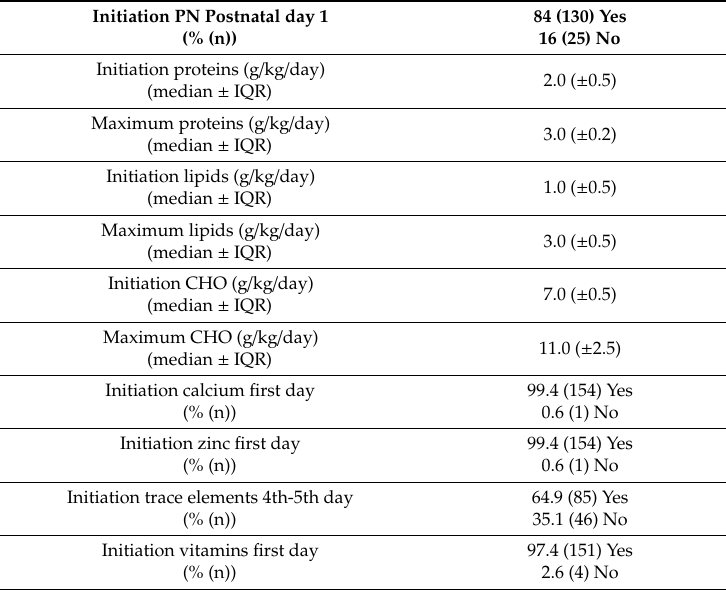
Table 2. Distribution of prescribed